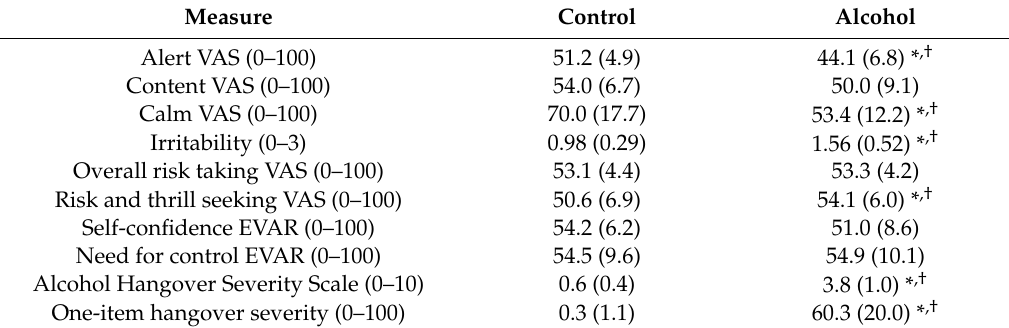
Table 1. Subjective assessments of mood and